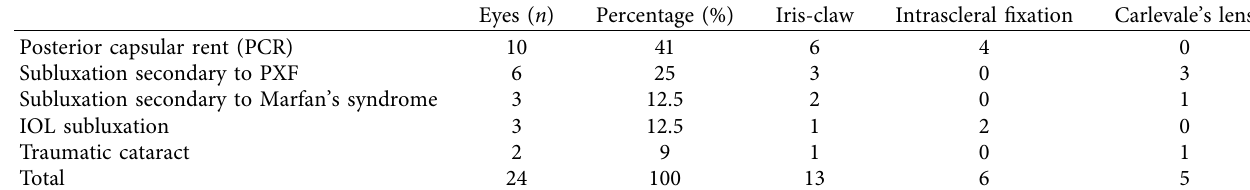
Table 1: Causes of capsular inadequate support and types of IOL